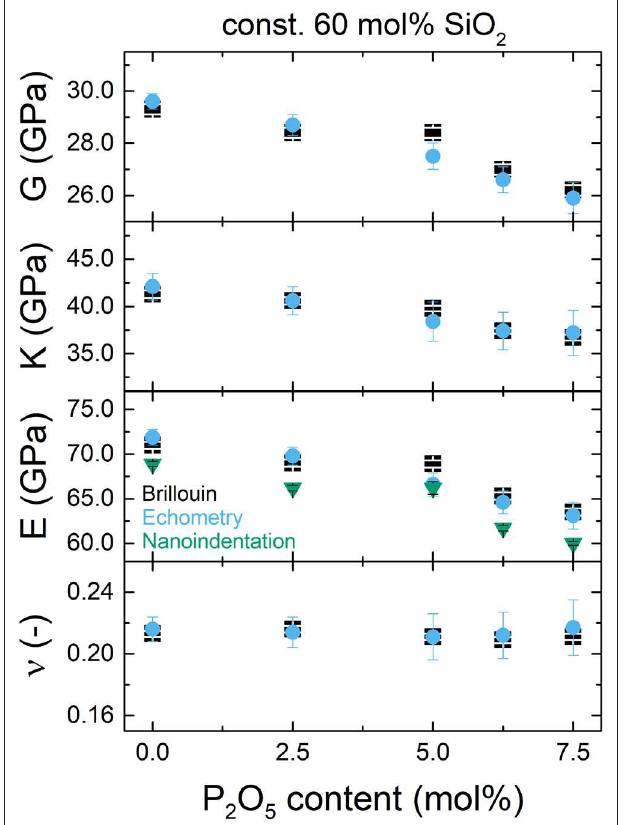
FIGURE 6 | Elastic properties obtained by Brillouin spectroscopy (black squares), ultrasonic echometry (blue circles) and nanoindentation (green triangles, only E) for glasses with 0 mol% P 2 O 5 and varying silica content: (from top to bottom) shear modulus (G), bulk modulus (K), Young’s modulus (E) and Poisson’s ratio ( ν